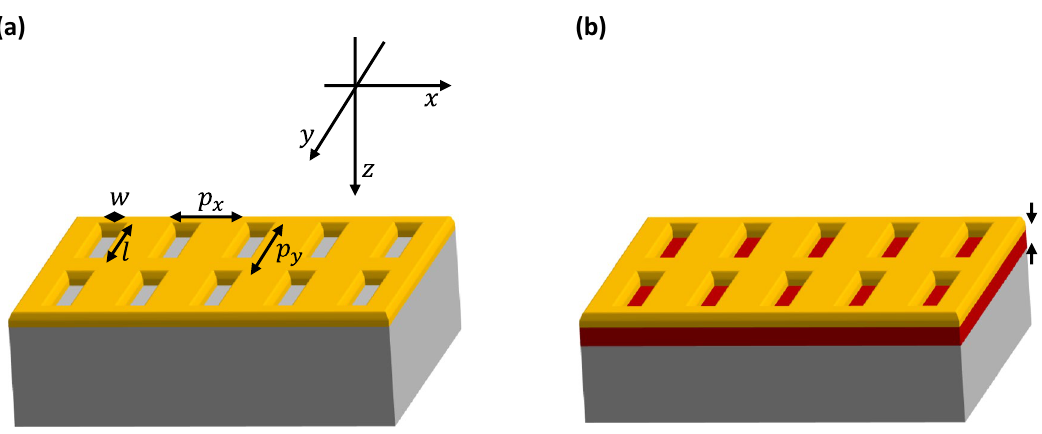
Figure 1. Schematics of typical ( a ) three-layer (superstrate/metal slot antenna array/infinite substrate) and ( b ) four-layer (superstrate/metal slot antenna array/thin film/infinite substrate)